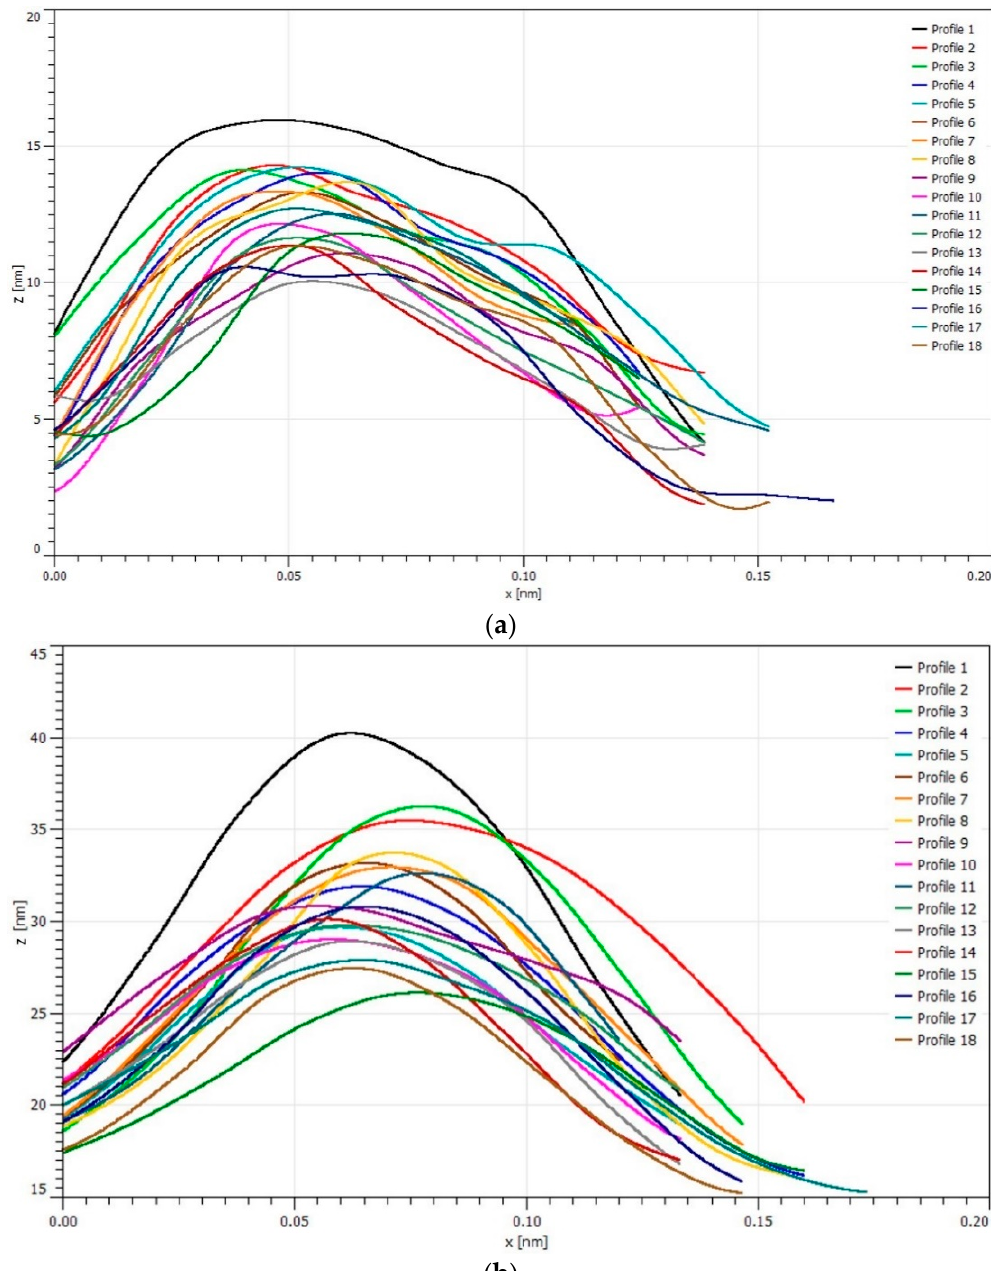
Figure 8. The graphs of the chosen effective points of the coated surfaces ( a ) Ag–Au 120 nm, and ( b ) Ag–Au 500 nm.